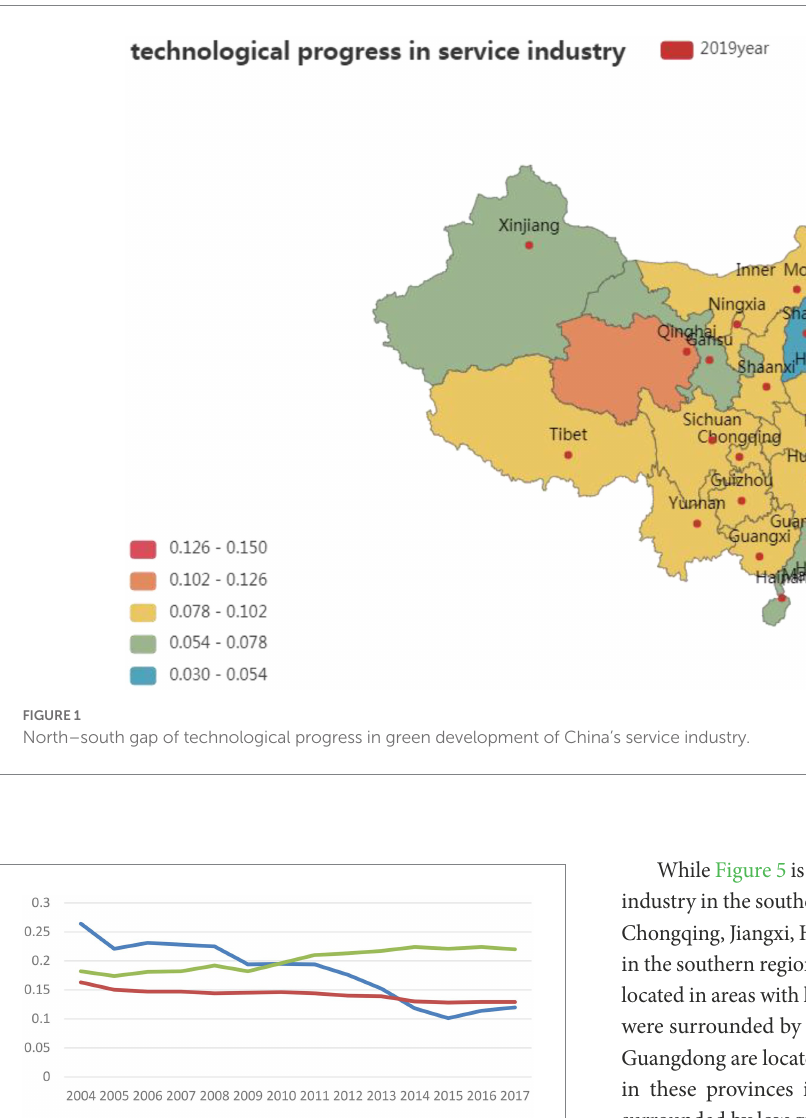
FIGURE 2 Line chart of Moran index from 2004 to